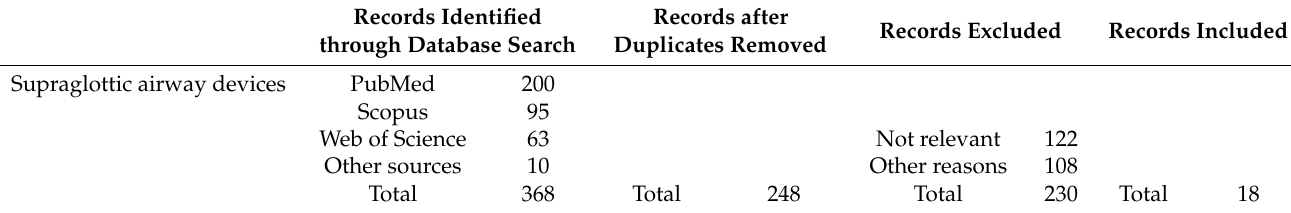
Table A1. Records retrieved from the databases for separate categories of the devices and their flow according to PRISMA 2009